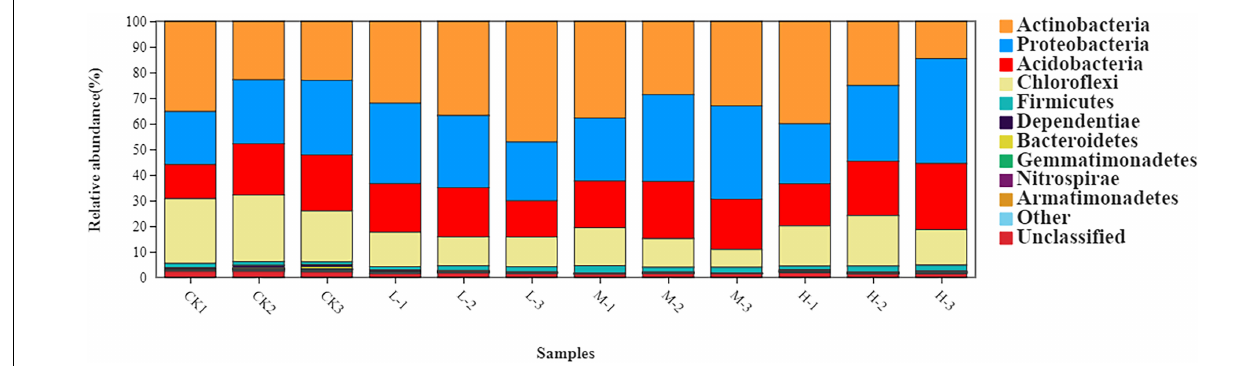
FIGURE 3 | Relative abundance of major bacterial phyla under four different nitrogen